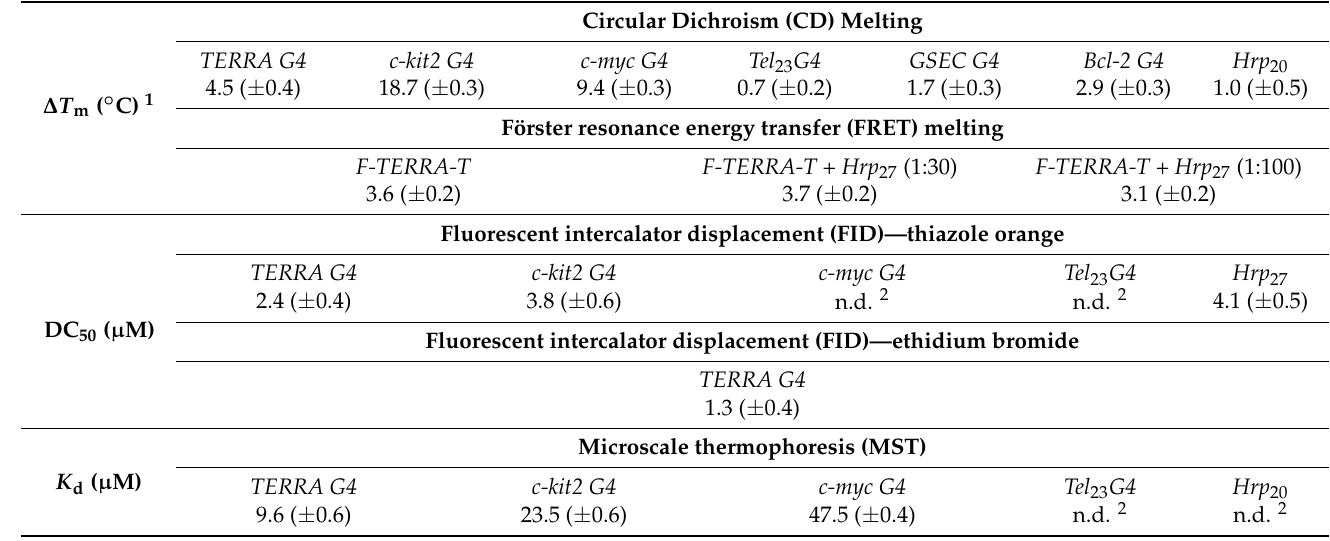
Table 1. Analysis of BPBA interaction with the investigated